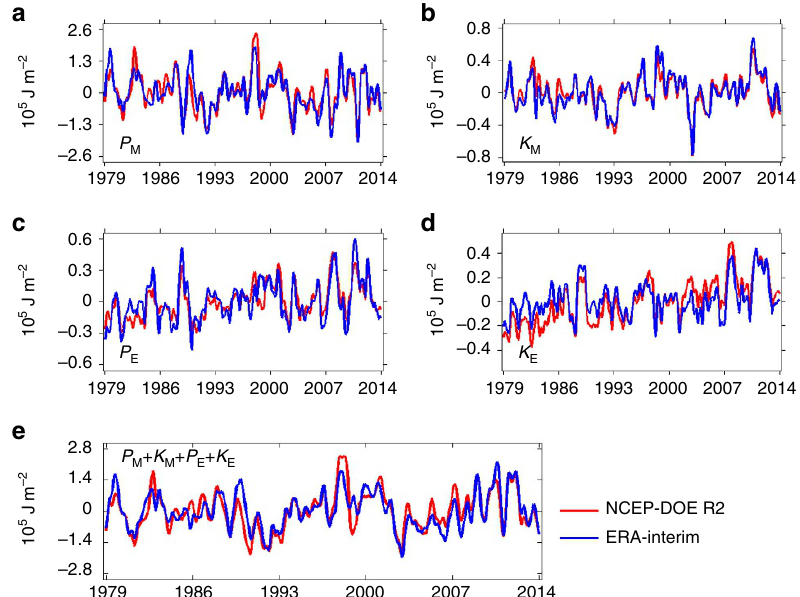
Figure 1 | Time series of the global-average atmospheric energies. ( a ) The mean available potential energy P M . ( b ) The mean kinetic energy K M . ( c ) The eddy available potential energy P E . ( d ) The eddy kinetic energy K E . ( e ) The total mechanical energy (that is, P M þ K M þ P E þ K E ).